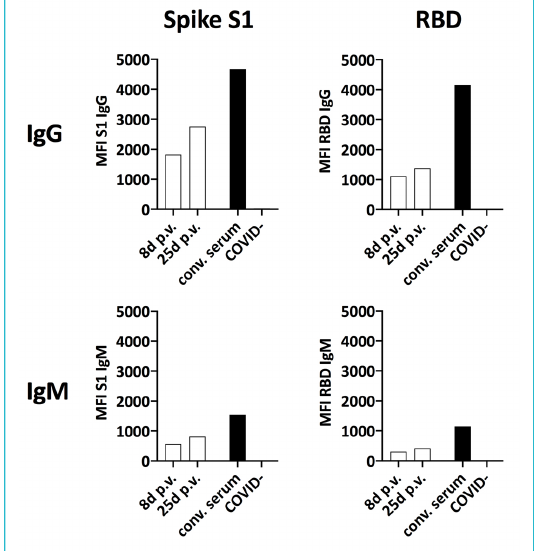
Figure 2: SARS-CoV2-specific anti-spike luminex assay. “conv. serum” = convalescent serum (n = 1), COVID- = negative control (serum from a non-infected person, n = 1); d: days; p.v.: post first vaccination; MFI: median fluorescence intensity; S1: SARS-CoV2 spike; RBD: receptor binding